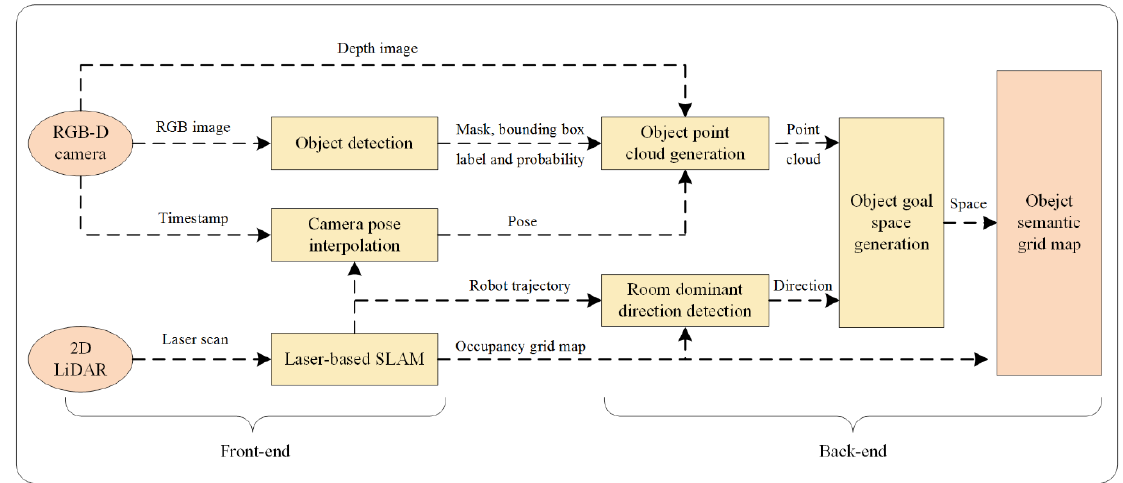
Figure 1. System overview. LiDAR: light detection and ranging and SLAM: simultaneous localization and mapping.